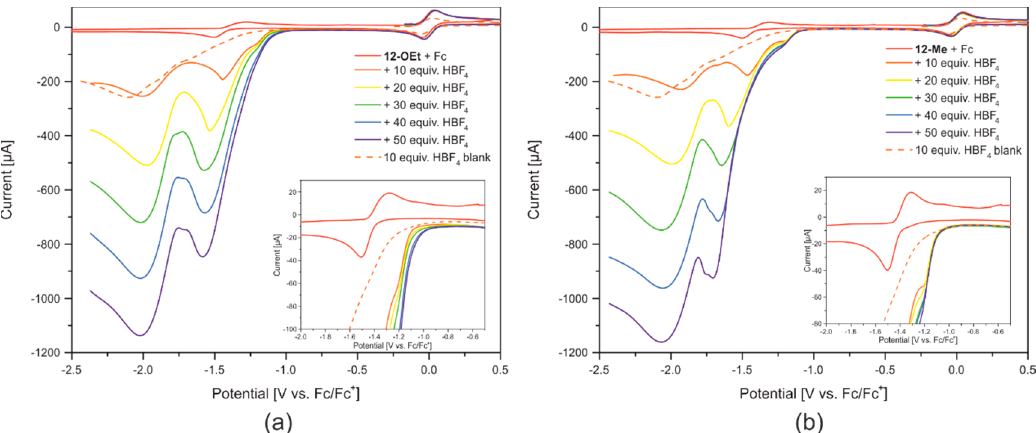
Figure 11. ( a ) CVs of 12-OEt; ( b ) CVs of 12-Me . Both figures show CVs in presence of 0 to 50 equivalents of HBF 4 in H 2 O. Both measurements were performed using a three-electrode setup utilizing a glassy carbon as working electrode and platinum-and silver wires as counter- and pseudo-reference electrode, respectively. Ferrocene was added as internal reference in all measurements.